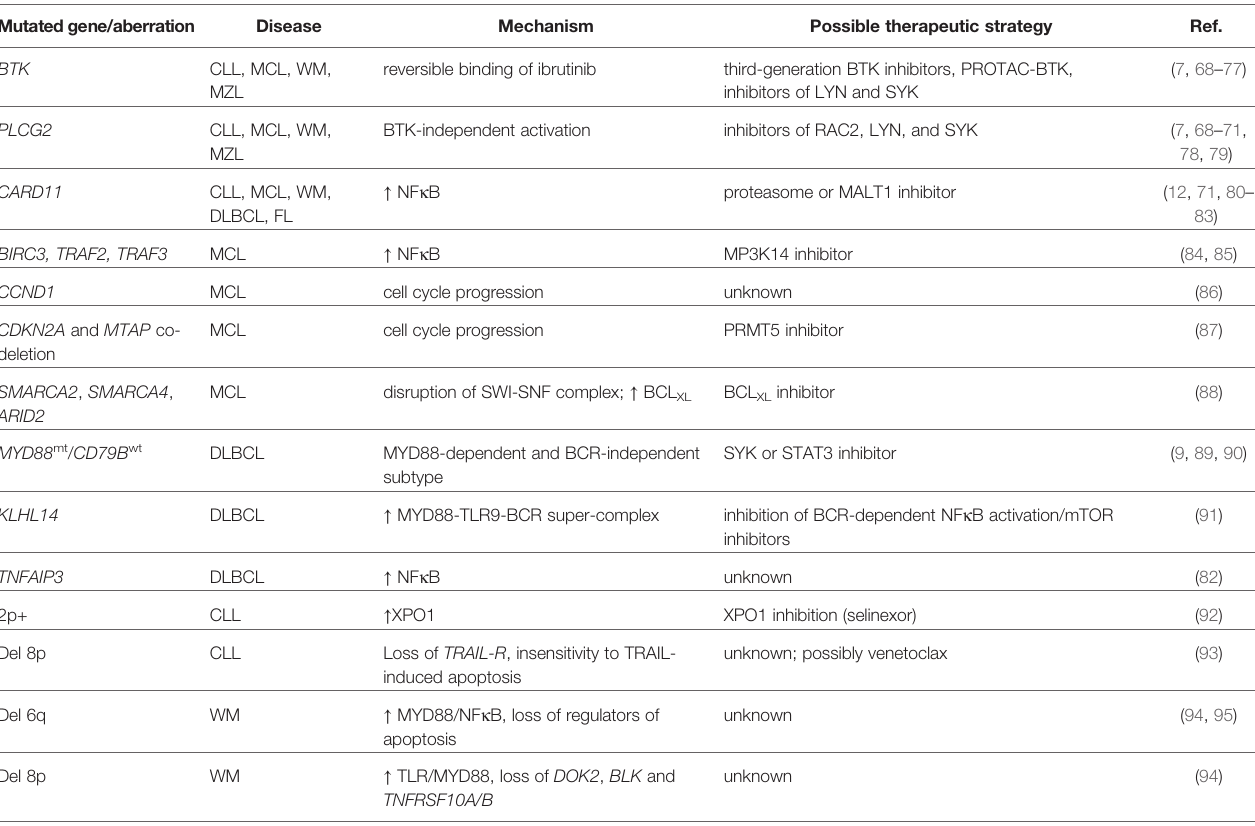
TABLE 1 | Recurrent mutations in ibrutinib-resistant patients and possible therapeutic strategies to overcome